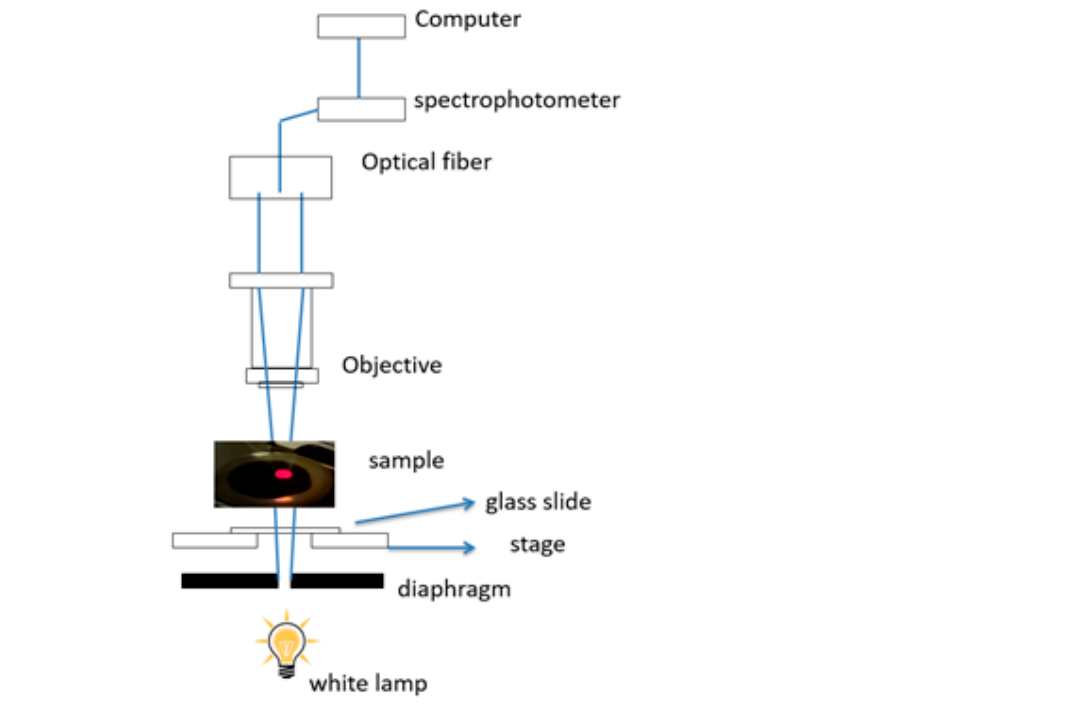
Figure 3. Ray diagram of light transmission setup. The onset shows the plasmonic device illuminated from the backside.